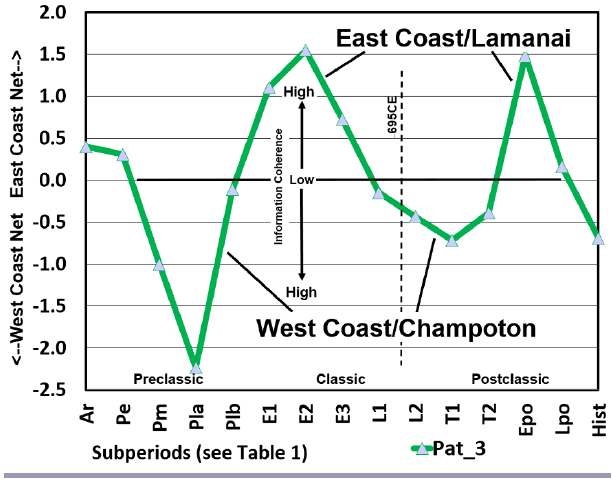
Fig. 9 . Maya seagoing shipping in the 11th century. Note the high prow and stern of the ships to prevent the canoes from being swamped by ocean waves. Oversized people and undersized ships are typical of non-Western depictions of sea travel. (Temple of the Warriors mural, Chichen Itza,